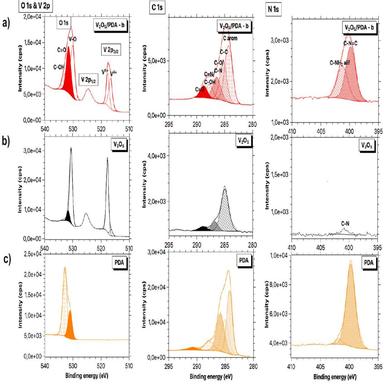
XPS high resolution spectra of O 1s & V 2p, C 1s and N 1s obtained for a) V2O5/PDA-b, b) V2O5 and c) polydopamine (PDA).